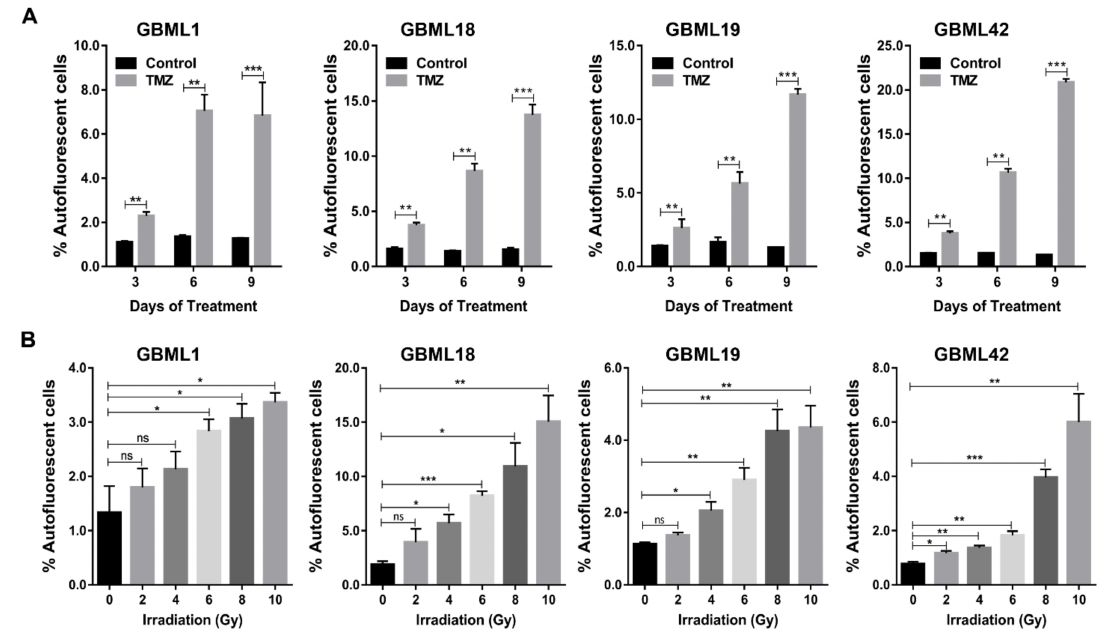
Figure 4. Temozolomide and radiation treatments increase the percentage of GBM autofluorescent cells. ( A,B ) Quantification of Fluo + percentage in control vs. Temozolomide (TMZ)–treated primary GBM cultures (GBML1, GBML18, GBML19, and GBML42; ( A ) and in control vs. irradiated cells (2, 4, 6, 8, and 10 Gy; ( B ). Data are represented as the mean ± SD of three independent experiments (* p ≤ 0.05, ** p ≤ 0.01, *** p ≤